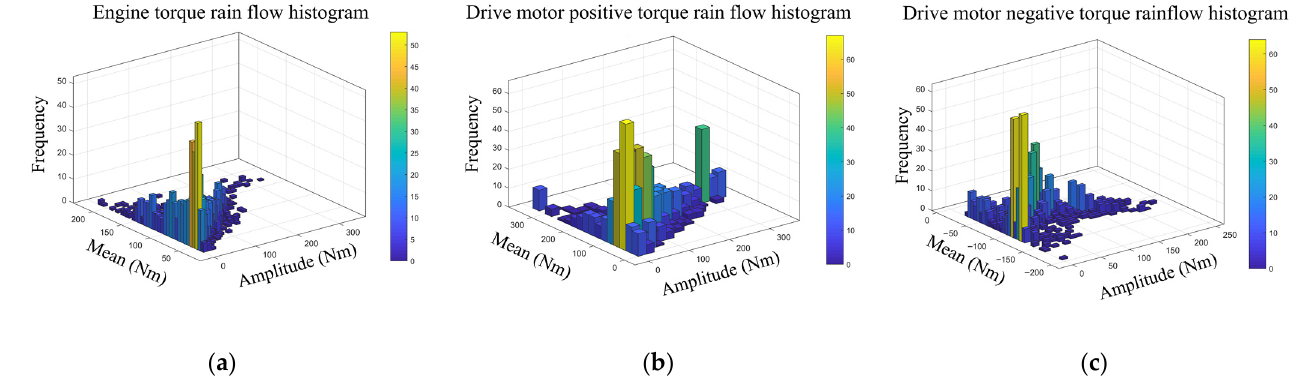
Figure 5. Torque rain flow matrix of each power source under urban conditions: ( a ) engine torque rainflow matrix, ( b ) drive motor positive torque rainflow matrix, ( c ) drive motor negative torque rainflow matrix.